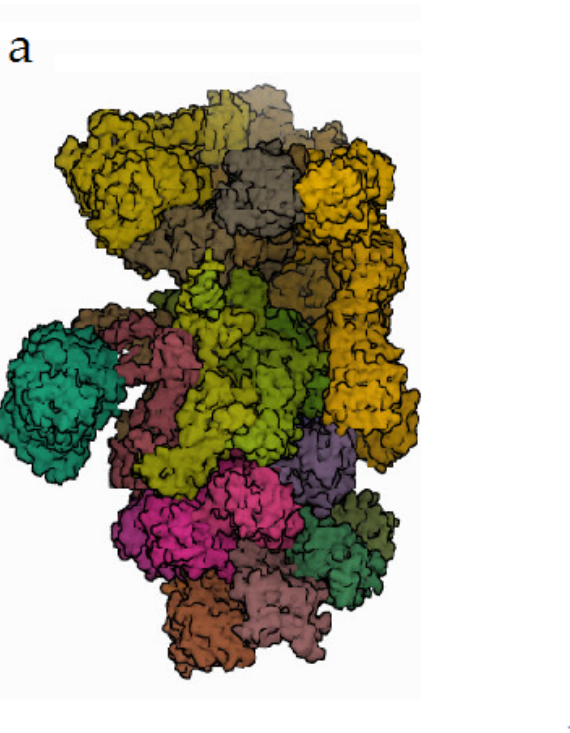
Figure 3. The human 26S proteasome. ( a ) Electron microscopy (PDB DOI: 10.2210/pdb5LN3/pdbEM Figure 3. The scheme of ubiquitination and the role of different types of ubiquitination in PD. Map EMD-4089: EMDB EMDataResource; deposited: 3 August 2016; released: 22 March 2017; dep- S—protein substrate, E1—ubiquitin-activating enzyme, E2—ubiquitin-conjugating enzyme, E3— ubiquitin ligase. Ubiquitin molecules are shown as green circles. Adapted from [35]. Table 1. Some PARK-designated genes and their protein products involved in inherited forms of Parkinson’s disease (modified from [30,31] and